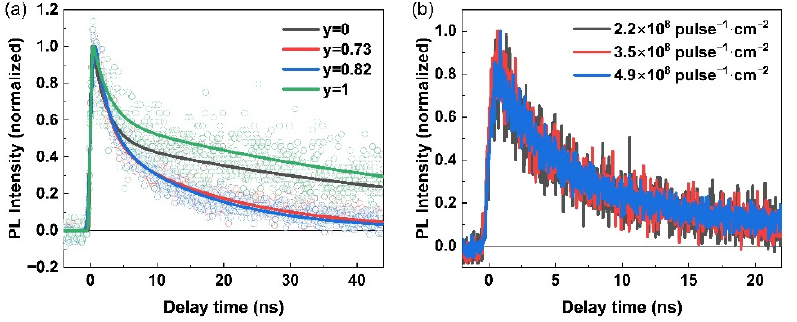
Figure 2. ( a ) TRPL kinetics of MAPb(Br 1 − y I y ) 3 SCs with indicated I composition after photoexcitation at 375 nm with an excitation fluency of 4.9 × 10 8 pulse − 1 · cm − 2 . The solid lines are fitting curves based on multi-exponential decay functions, and the detailed fitting parameters are shown in Table 2. ( b ) TRPL kinetics of MAPb(Br 0 . 18 I 0 . 82 ) 3 SCs at different excitation fluencies. Table 2. Fitting parameters for TRPL and TRMC kinetics of MAPb(Br 1 − y I y ) 3 single crystals with different Br